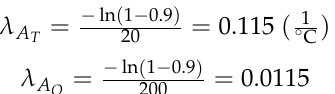
Table 2. Diagnosis matrix of the main bearing of the wind turbine discussed in this case study.